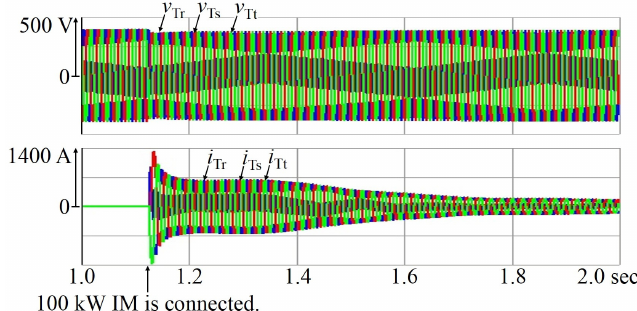
Figure 6. Simulated waveforms of the direct connection for the 100-kW SCIM.